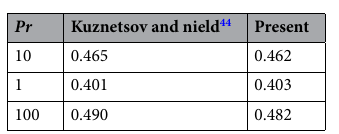
Table 1. Comparison of present results with published work 44 .